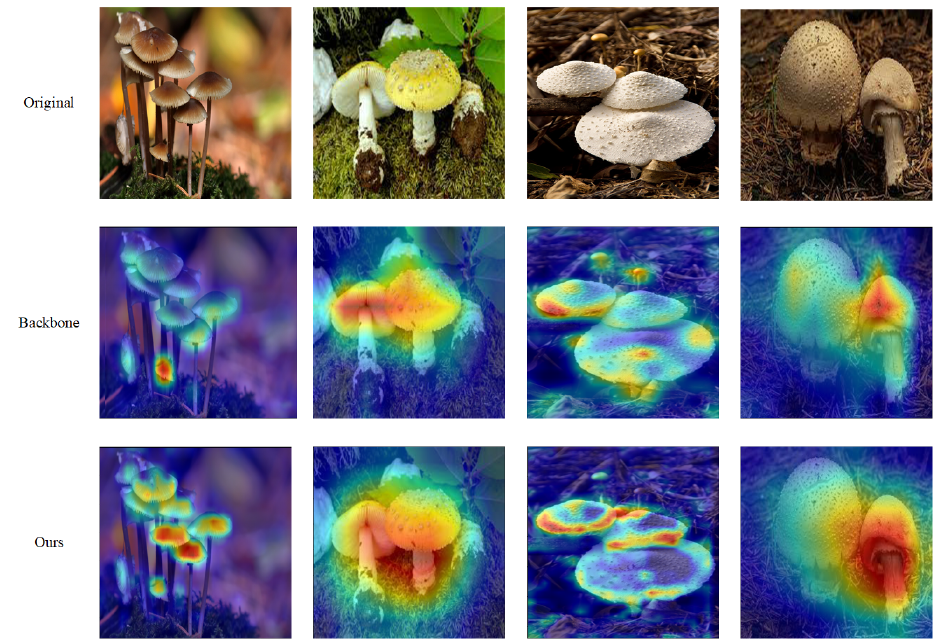
Figure 12. The thermodynamic diagrams of backbone model and